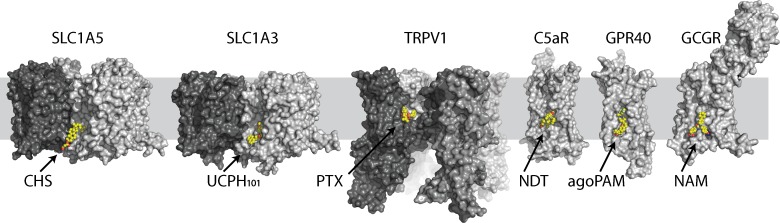
Selective examples of allosteric druggable pockets at the lipid-exposed surface near the intracellular part of membrane proteins.Different protomers are shown in surface with different gray scale. Each ligand is colored in yellow ball-and-sticks. Examples of allosteric sites include the RTX agonist binding site in the capsaicin and heat-activated cation channel TRPV1 (Gao et al., 2016), the extra-helical NDT9513727 antagonist binding site in the complement C5a receptor (Robertson et al., 2018), the agoPAM binding site in the free fatty acid receptor GPR40 (Lu et al., 2017) and a negative allosteric modulator binding site in the glucagon receptor (Zhang et al., 2017).